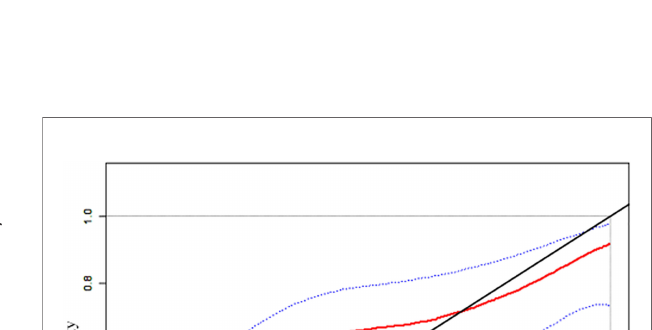
FIGURE 3 | A nomogram composed of the independent risk factors to predict the probability of peritoneal dissemination for patients with gastric cancer. The risk value of PD was calculated by drawing a vertical line to the point to the axis on each of the variables. Add the points of each variable and locate them on the total point line, and then the individual predictive value for PD was obtained by projecting the vertical line from the total point line to the bottom scale of the prediction probability.